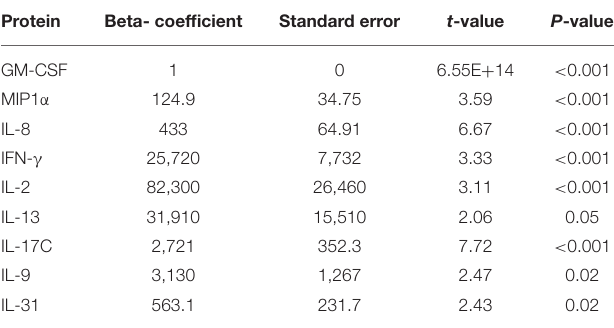
TABLE 3 | Model estimates from the univariate non-parametric model to investigate the association between the mean viral load of volunteers and the concentration of proteins in peripheral